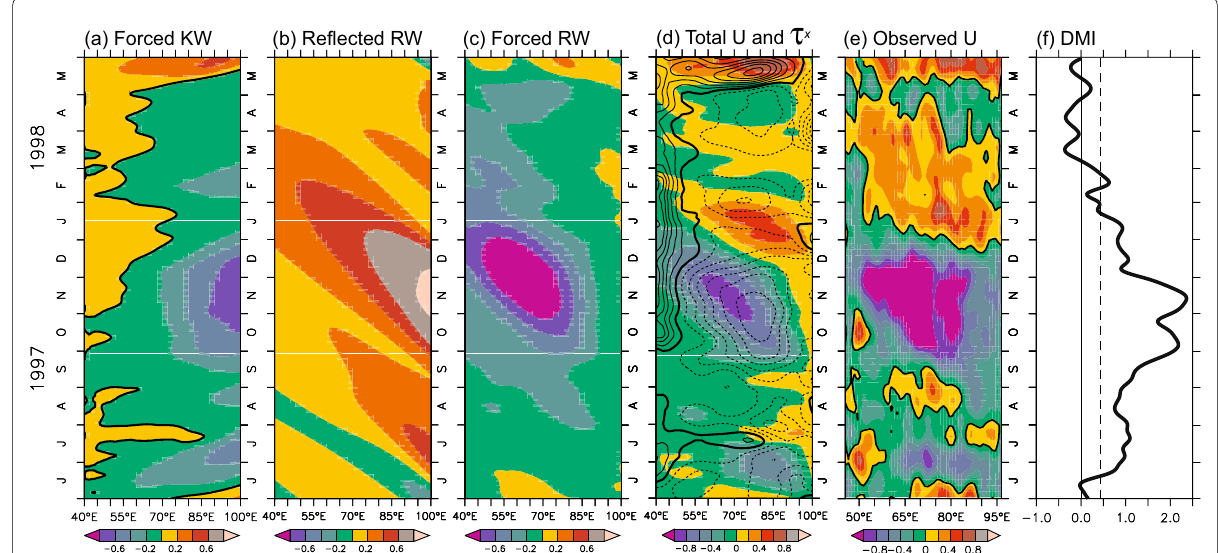
Fig. 4 Time-longitude diagrams of model zonal current anomalies (ms − 1 ) at 15 m depth along the equator for June 1997–May 1998, from a wind-forced Kelvin waves, b eastern-boundary-generated Rossby waves, c wind-forced Rossby waves, d the total model solution, e the observed zonal current from OSCAR, and f the DMI. The contours in Fig. 4d show anomalies of zonal wind stress along the equator. The solid (dotted) lines are for westerly (easterly) anomalies. Contour interval is 1.5 10 –2 N m − 2 with zero contour highlighted. Note the scales change in d and ×